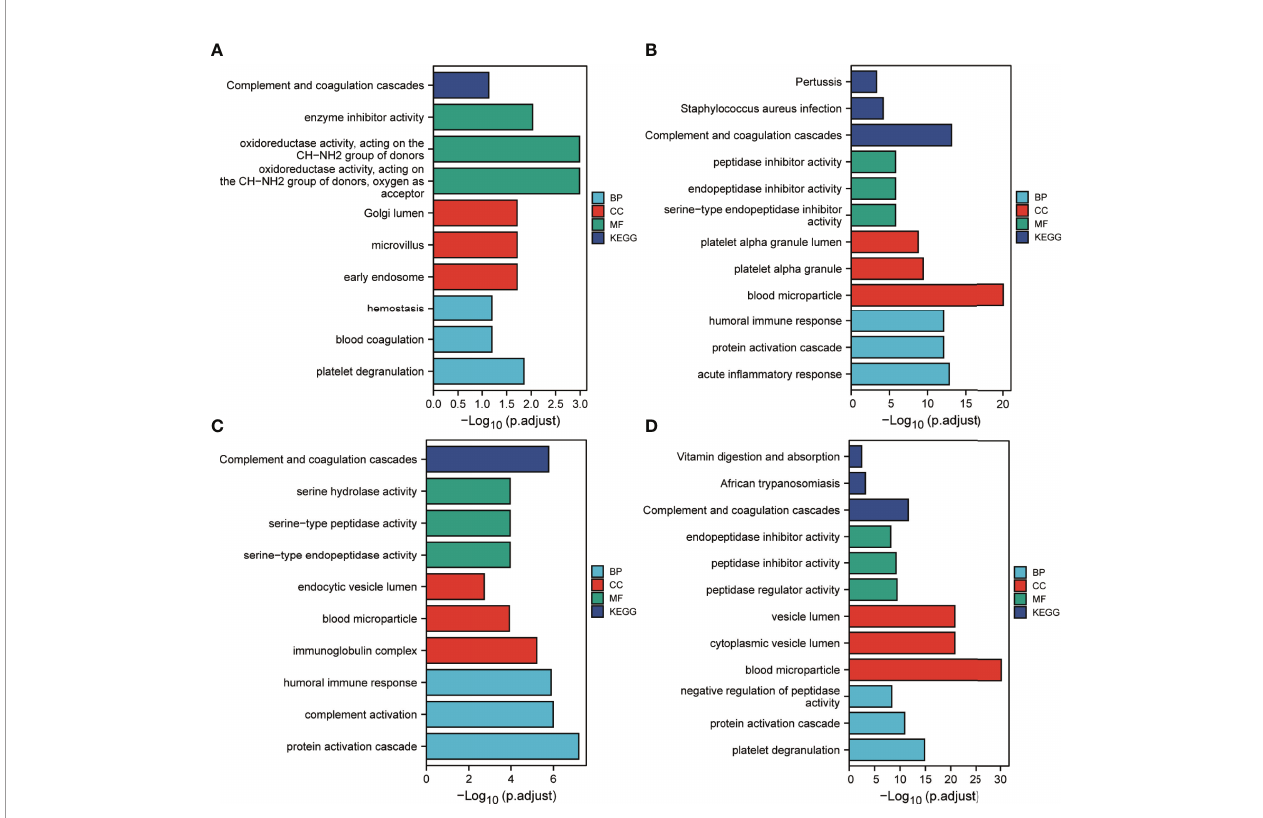
FIGURE 8 | Functional enrichment analysis of IC bene fi ts-related proteins. (A – D) Results corresponding to functional enrichment analysis of proteins in clusters 1, 2, 7 and 8,